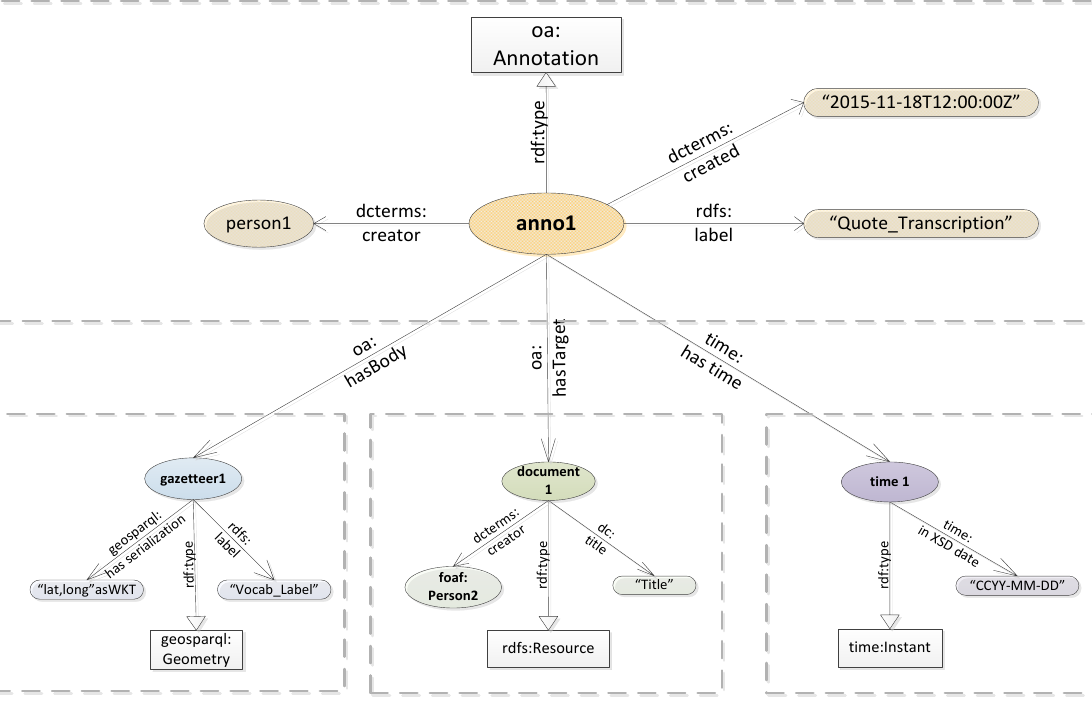
Figure 8. TLCMap ontology model extends based on the Open Annotation Collaboration ontology model.